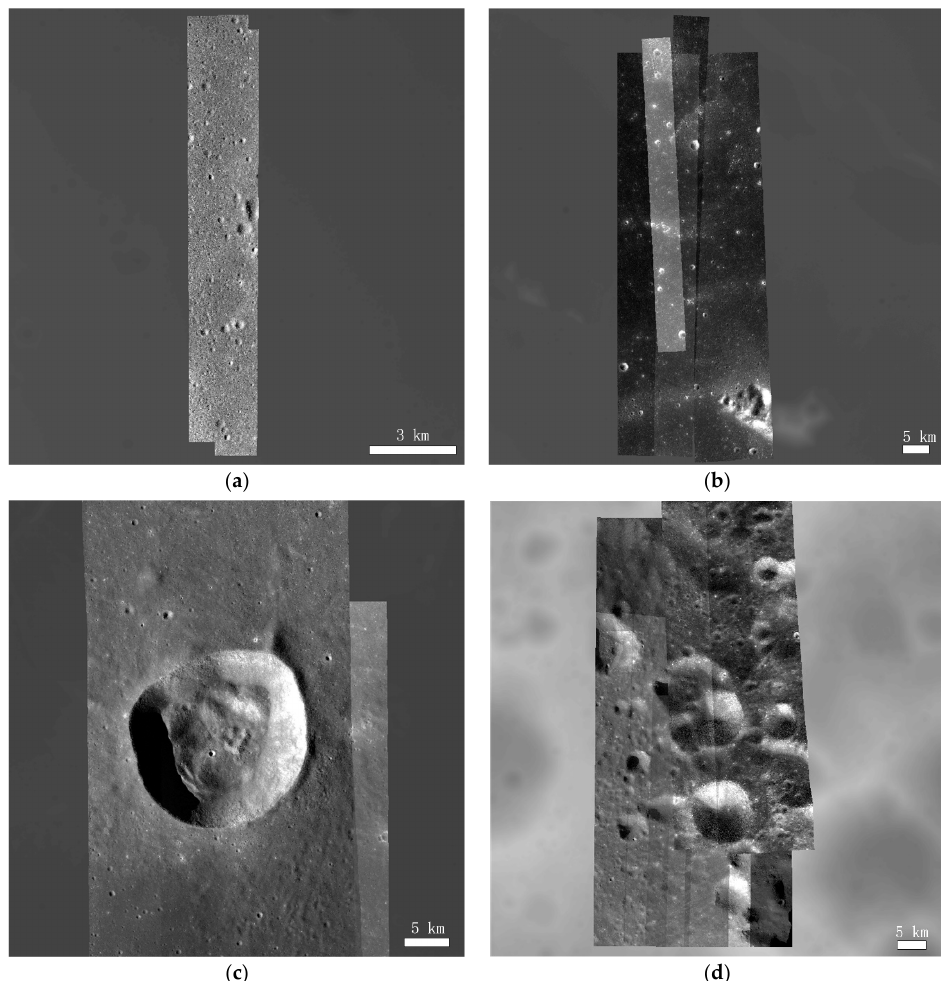
Figure 4. The LROC NAC images of the four test areas displayed on SLDEM: ( a ) Apollo 11; ( b ) Imbrium; ( c ) Lichtenberg; ( d ) Hponds.